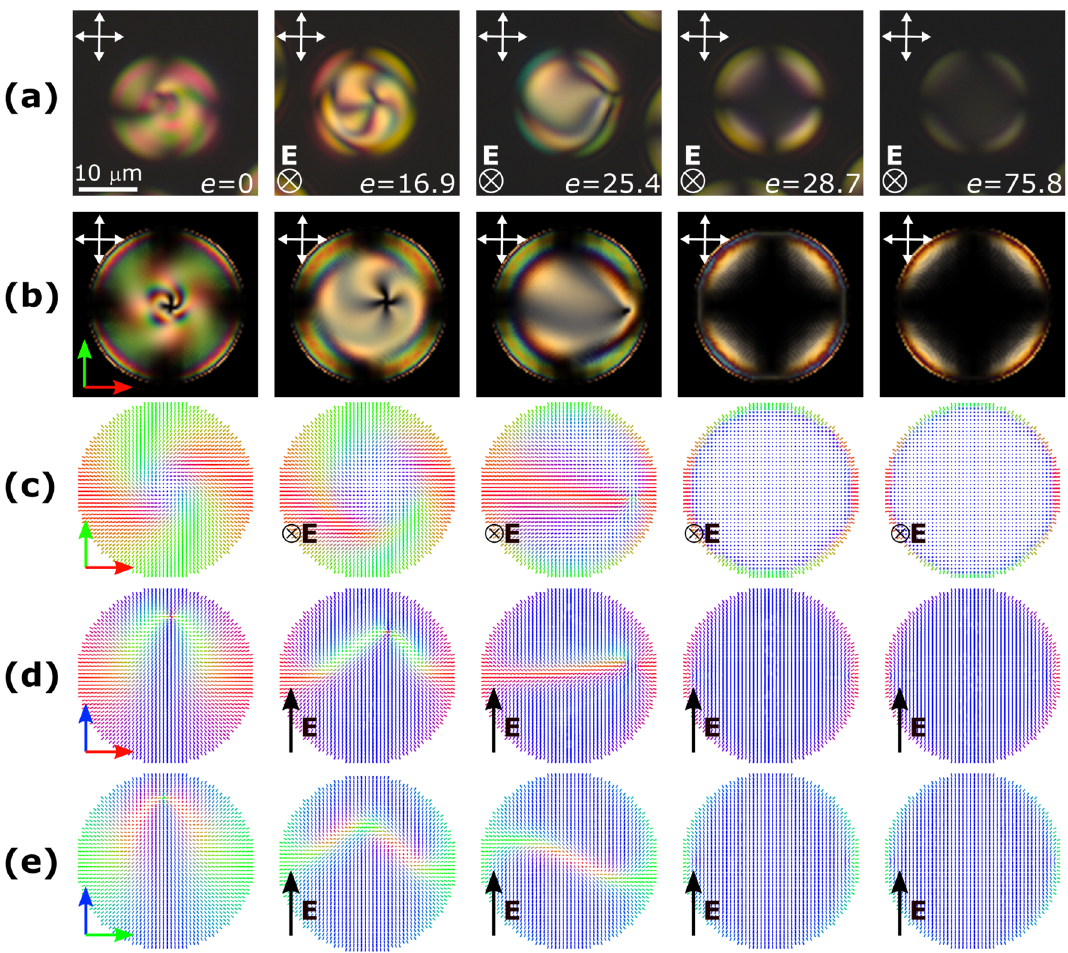
Figure 3. Sequence of structures for the asymmetric transition scenario in increasing electric field. Experimental cross-polarized microscopy images, N 0 = 2.4 ( a ), and simulated cross-polarized images ( b ) and director distribution in primary cross cuts ( c – e ) for E7, N 0 = 2.5 .